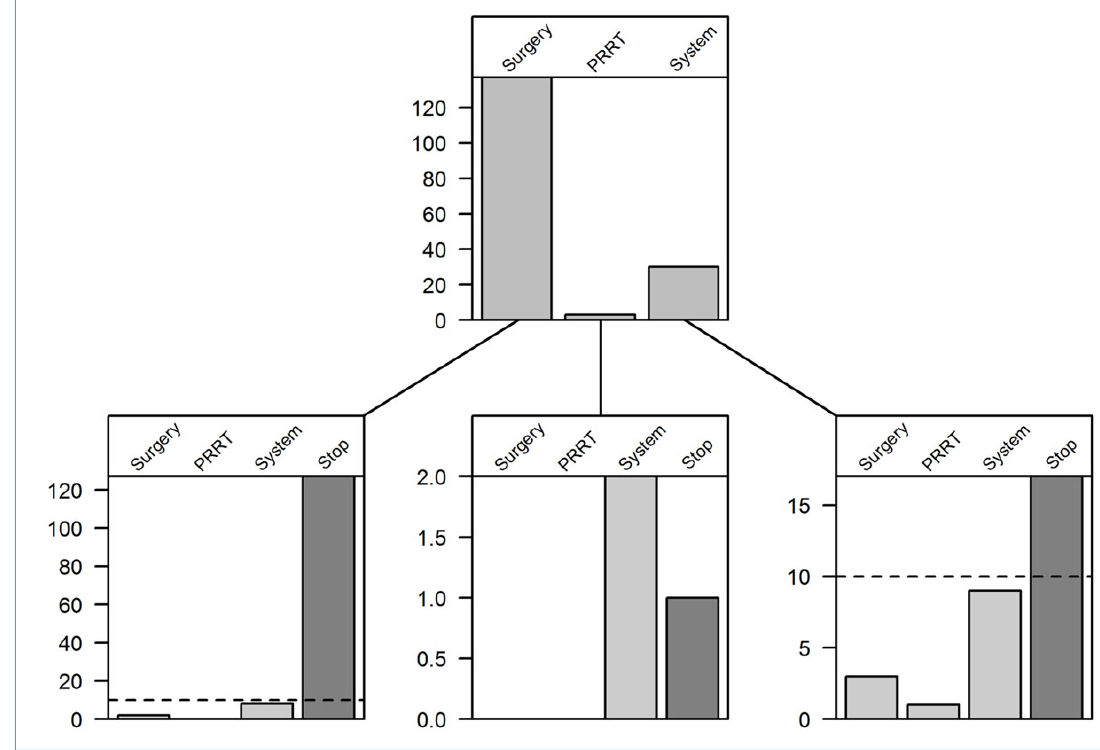
Figure 3: Tree plot for lung neuroendocrine tumours based on the secondary analysis set.Each row represents a therapy line. Stop indicates that no more treatments were documented. (n = 170 patients). PPRT = peptide receptor radionuclide